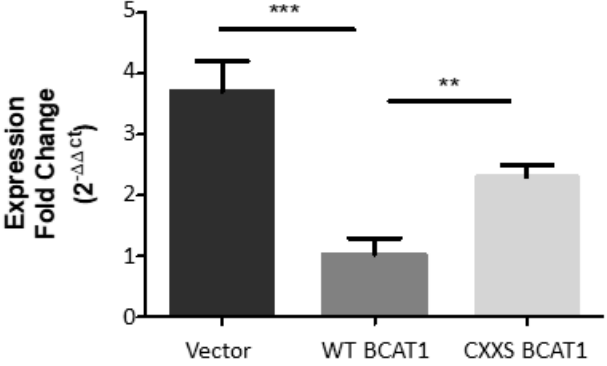
Figure 9. Thioredoxin Reductase (TrxRD1) relative gene expression in U937 cells. Graph displaying fold change in TrxRD1 expression in transgenic U937 cells. Significant differences were calculated using 1-way ANOVA with Tukey’s post-test where, ** p < 0.01 and *** p < 0.001 ( n = 3).